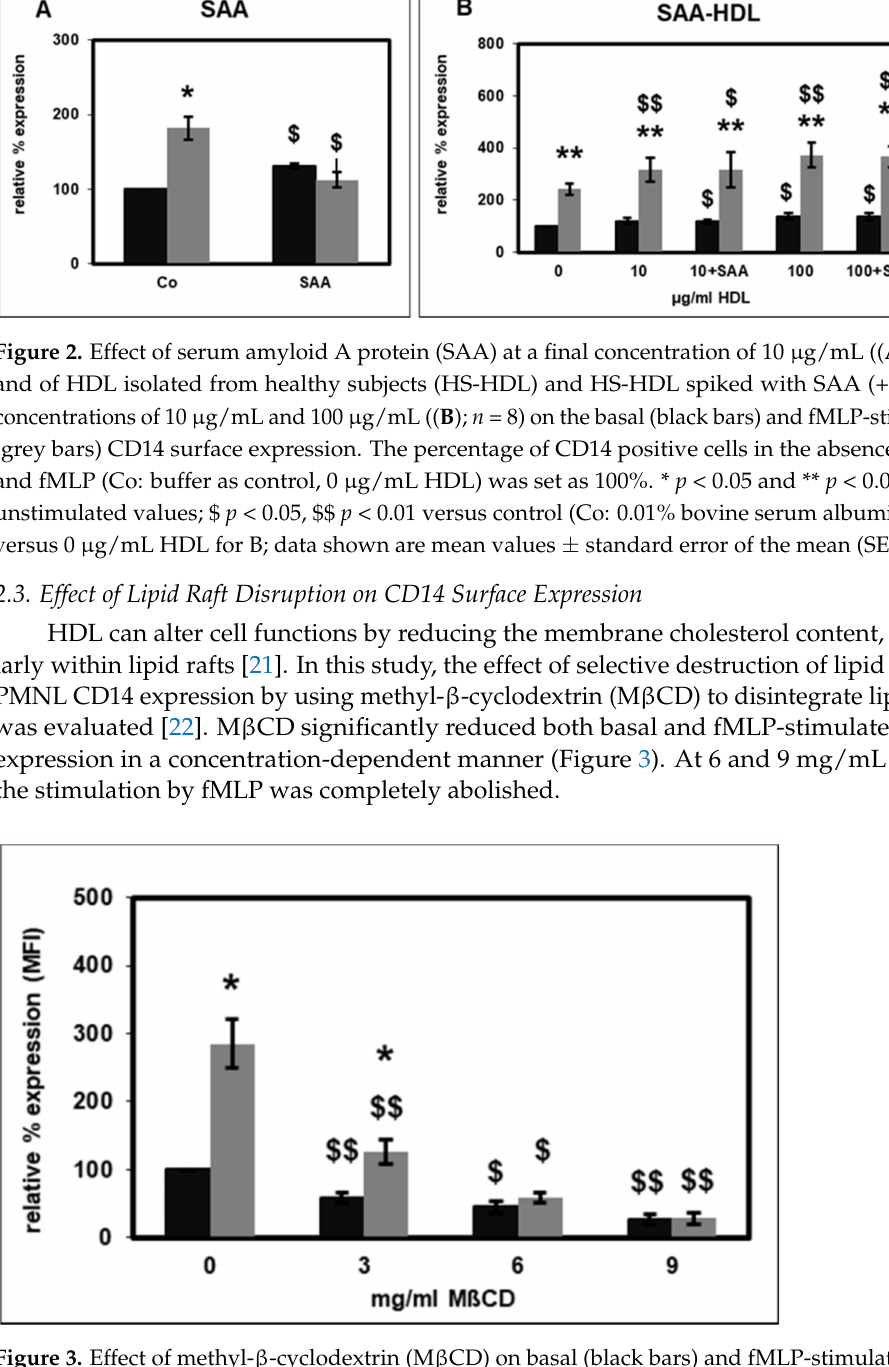
Figure 3. Effect of methyl- β -cyclodextrin (M β CD) on basal (black bars) and fMLP-stimulated (grey bars) CD14 surface expression. The unstimulated CD11b expression measured as mean fluorescence intensity (MFI) in the absence of M β CD was set as 100%. n = 5 for 0 and 3 mg/mL M β CD; n = 3 for 6 and 9 mg/mL M β CD. * p < 0.05 versus the unstimulated values; $ p < 0.05 and $$ p < 0.01 versus the absence of M β CD; data shown are mean values ±